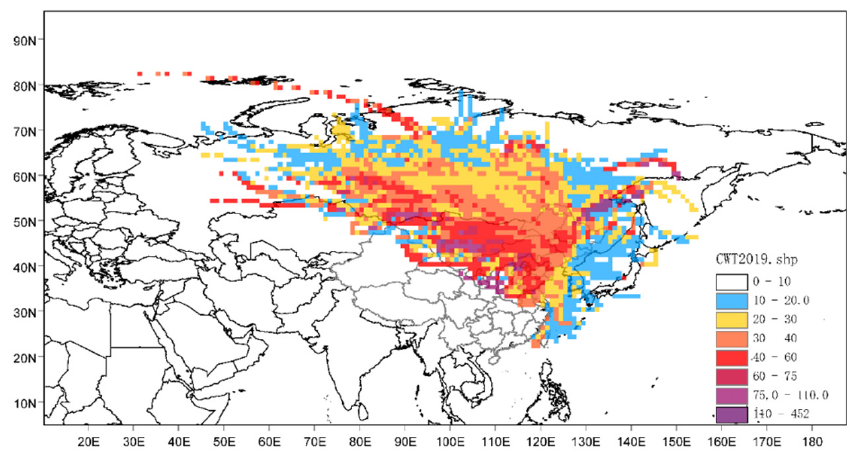
Figure 12. Concentration trajectory weighting method (CWT) values for PM 2.5 .